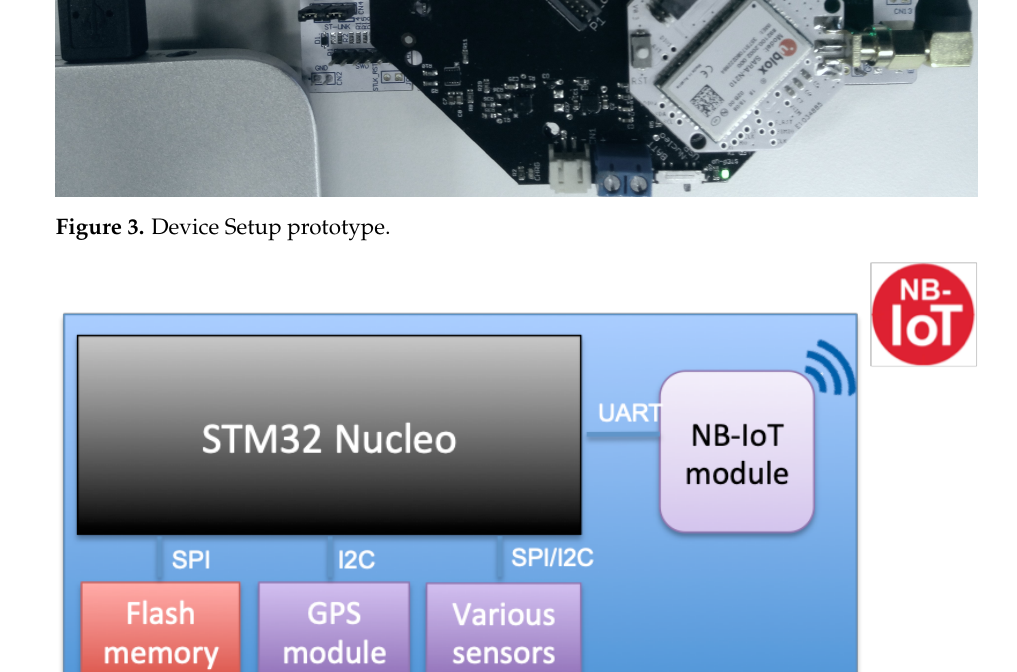
Figure 4. Sensor device